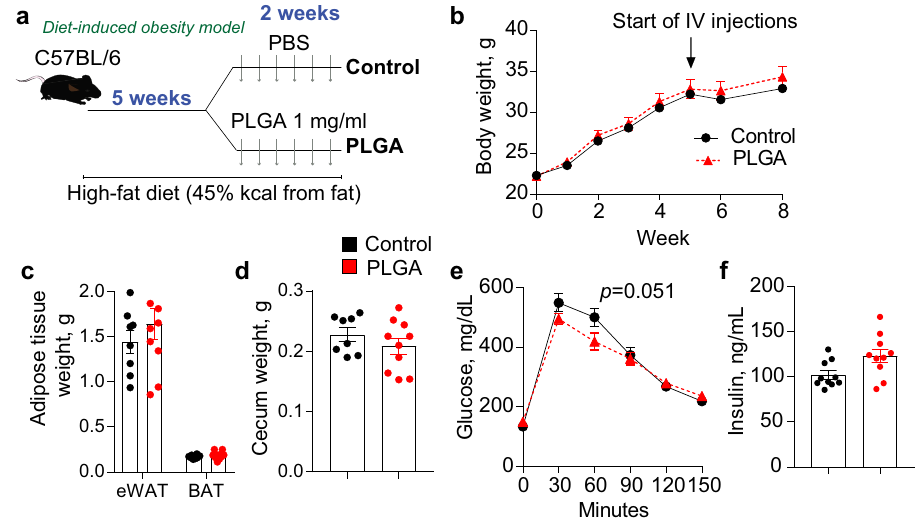
Figure 1. Effect of PLGA on body weight and glucose metabolism in diet-induced obese mice. ( a ) C57BL/6 mice were fed a high-fat diet for 5 weeks and were then injected IV with either PLGA nanoparticles or PBS six times during two weeks; ( b ) Body weight throughout experiment and ( c ) adipose tissue and ( d ) cecum weight at the end of the study were not significantly altered by treatment; ( e ) IPGTT before euthanasia revealed that PLGA nanoparticle-injected animals presented significantly better glucose clearance at 60 min (n = 10 mice/ group); ( f ) Fasting insulin was not different between groups. n = 10 mice/group, independent t -test, p <